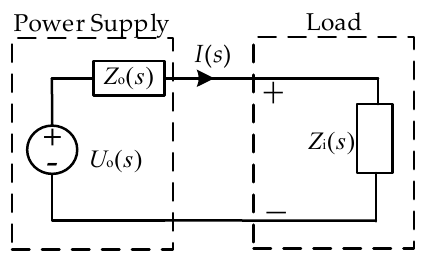
Figure 2. Structure schematic diagram of impedance stability criterion.